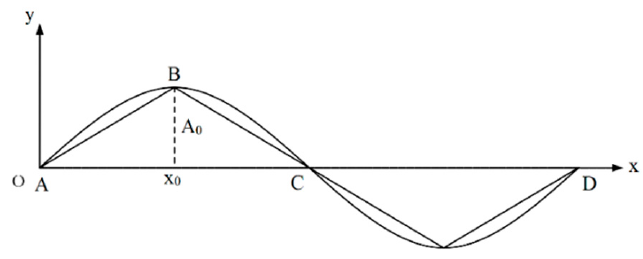
Figure 2. Schematic diagram of cable body vibration.